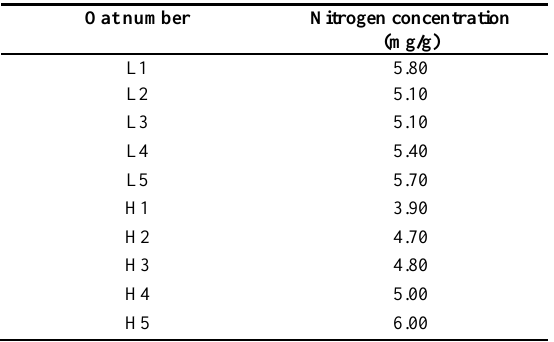
Table 1 Laboratory analysed nitrogen concentration of